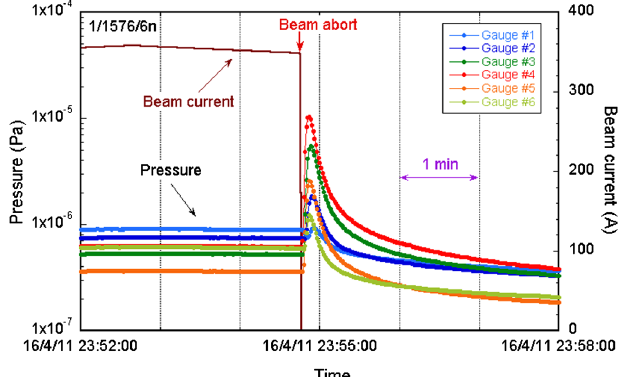
FIG. 14. Number of pressure bursts per 50 h (red bars), beam current when each burst occurred (blue circles), and maximum beam current (black line) as functions of the duration of operation with a beam current greater than 50